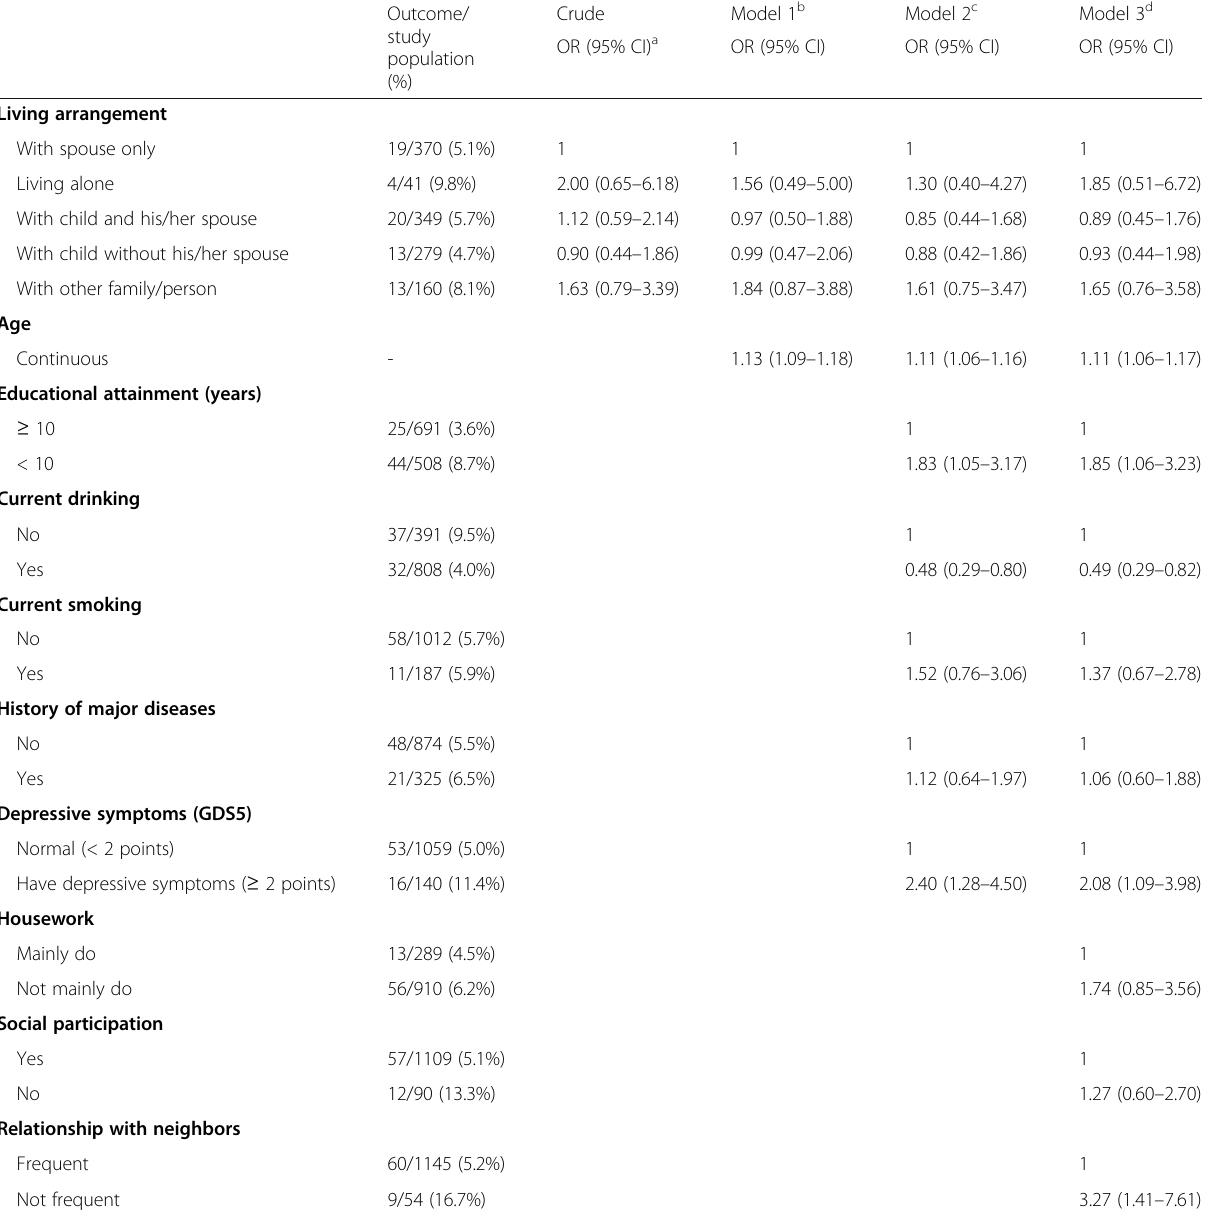
Table 2 Association between living arrangement and decline in functional capacity after three years for men ( n =